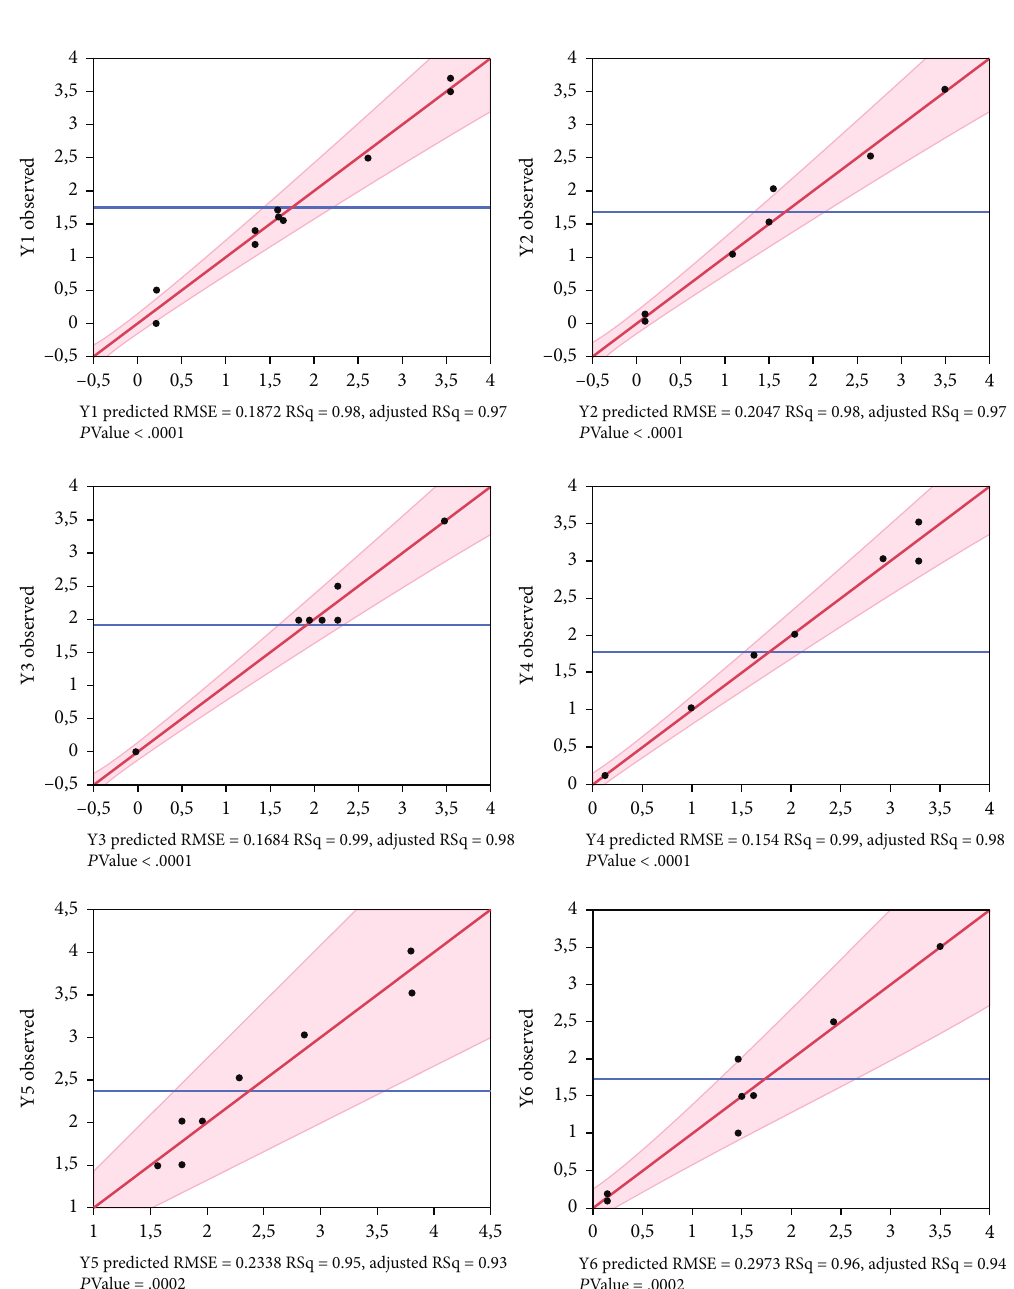
Figure 2: Graph of observed values versus predicted values. Y1: color, Y2: taste, Y3: fl avor, Y4: texture, Y5: aroma; Y6: overall